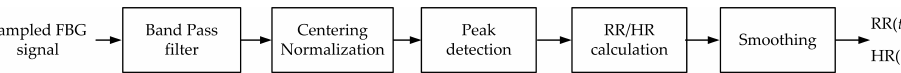
Figure 7. Signal processing from the FBG sensor to determine respiratory and heart rate